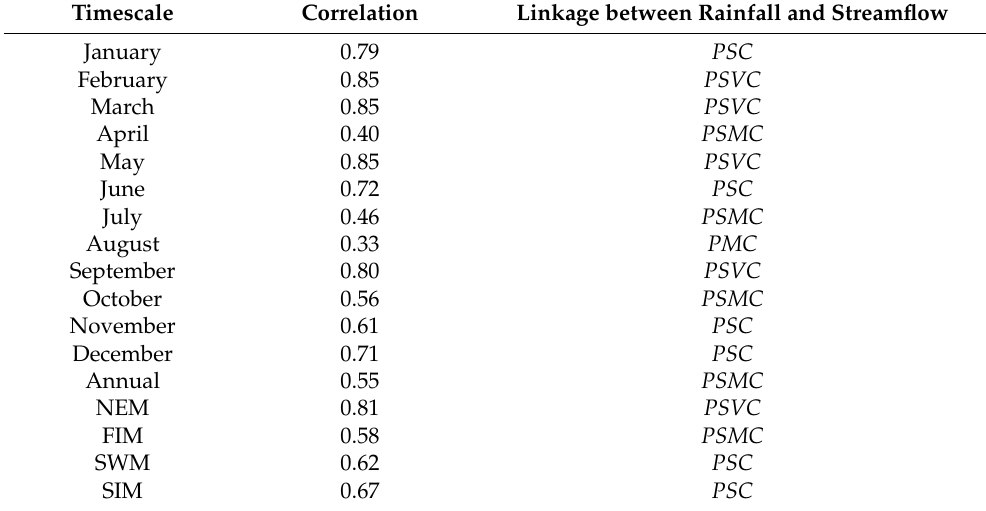
Table 9. Pearson correlation results.